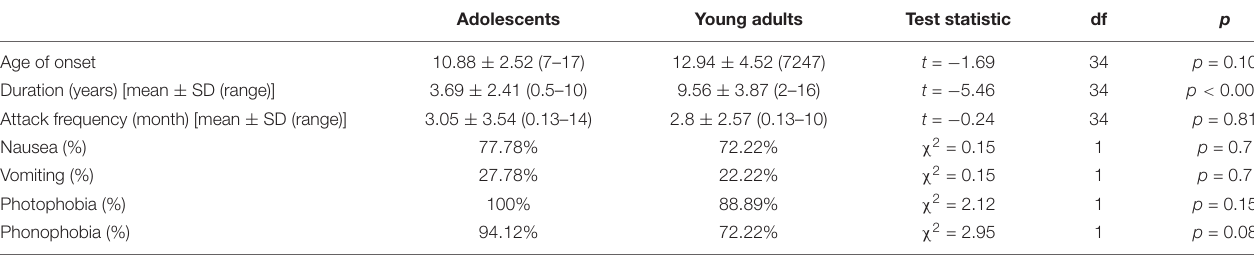
TABLE 2 | Migraine patient characteristics by developmental age.